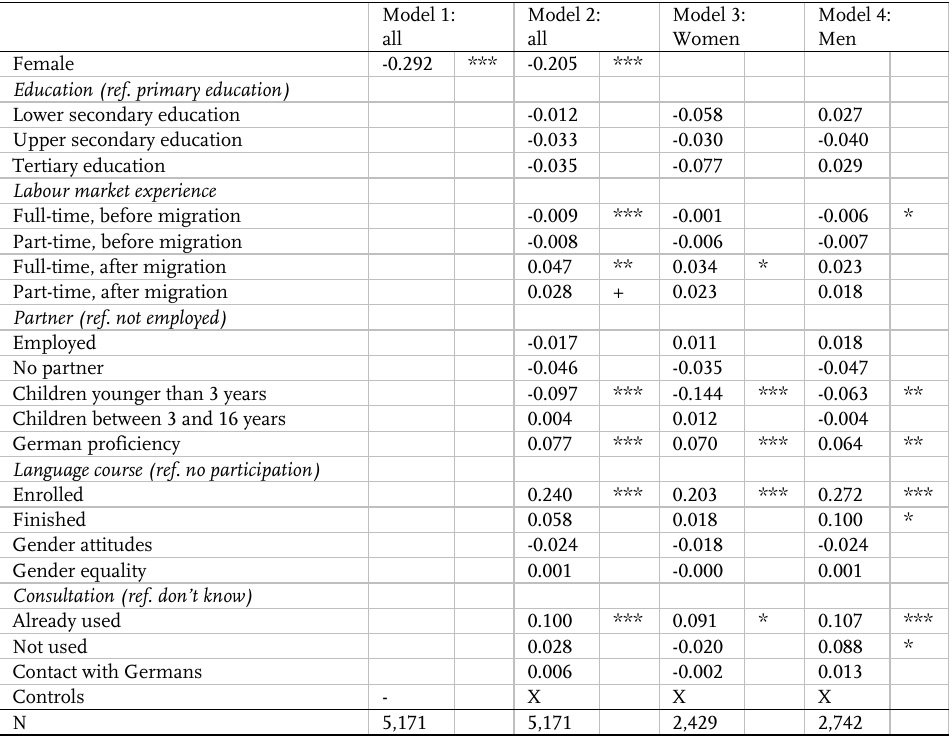
Model 1: Model 2: Model 3: Model 4: all all Women Men